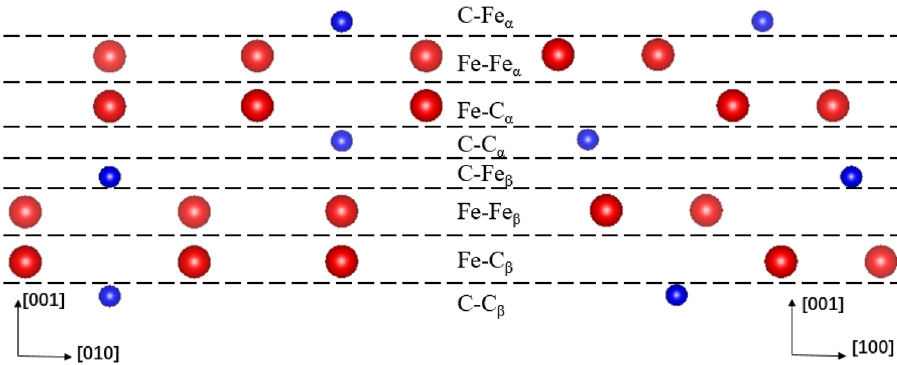
Figure 4. Plane classification of cementite